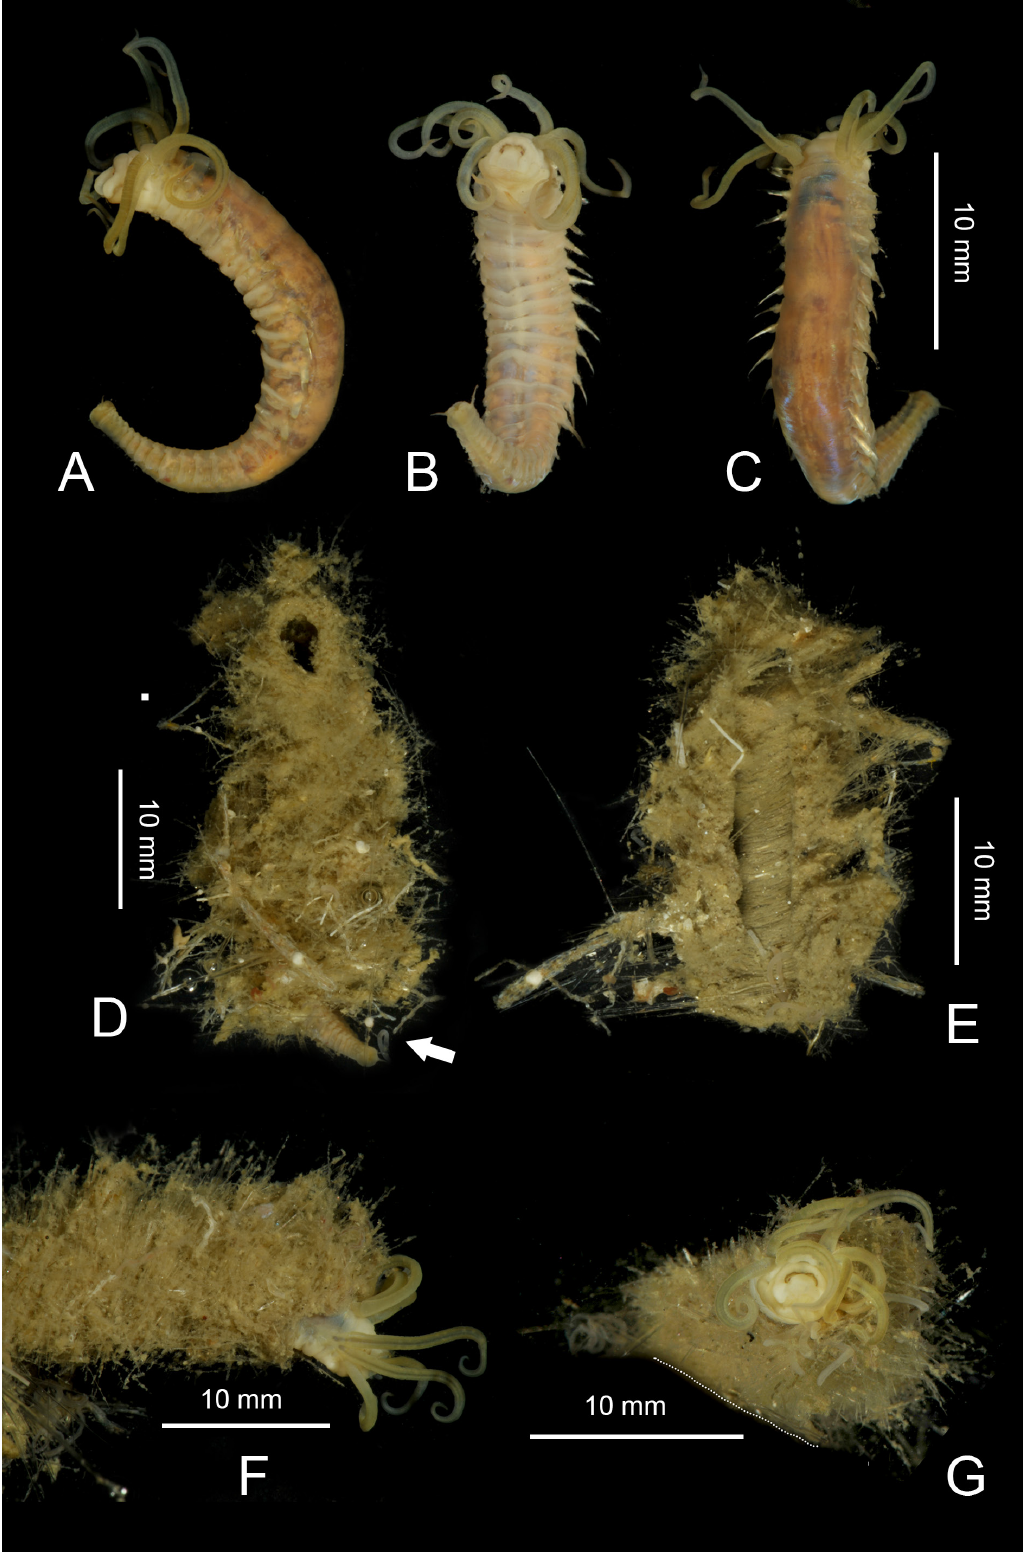
Fig. 2. Amage giacomobovei sp. nov., morphology. A–C . Lateral, ventral and dorsal views of the holotype (MNA-06373). D–E . Morphology of the tube. F–G . Paratype